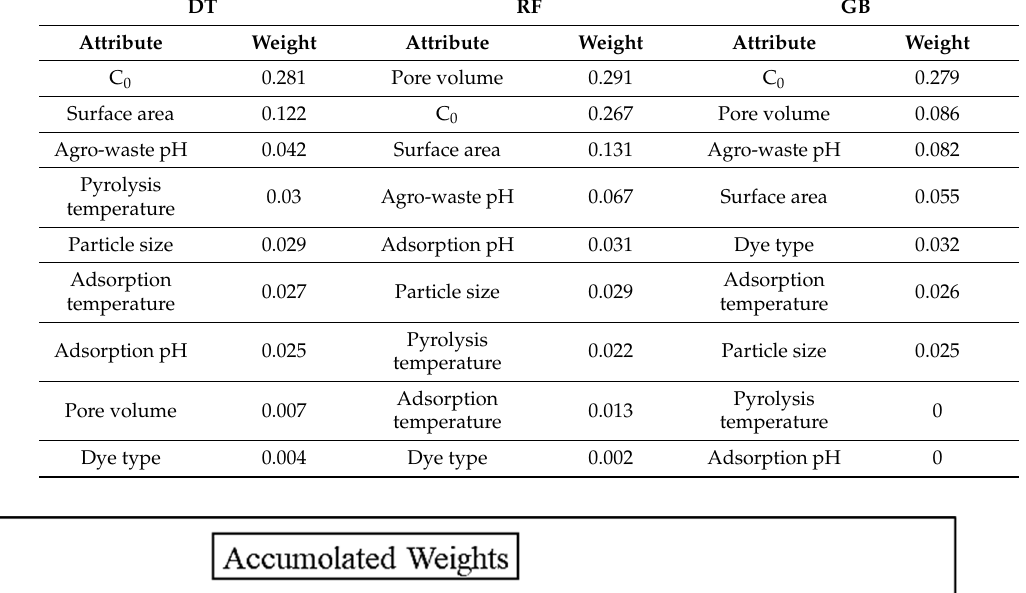
Table 1. Importance score (weight) of variables based on three machine learning (ML) methods.